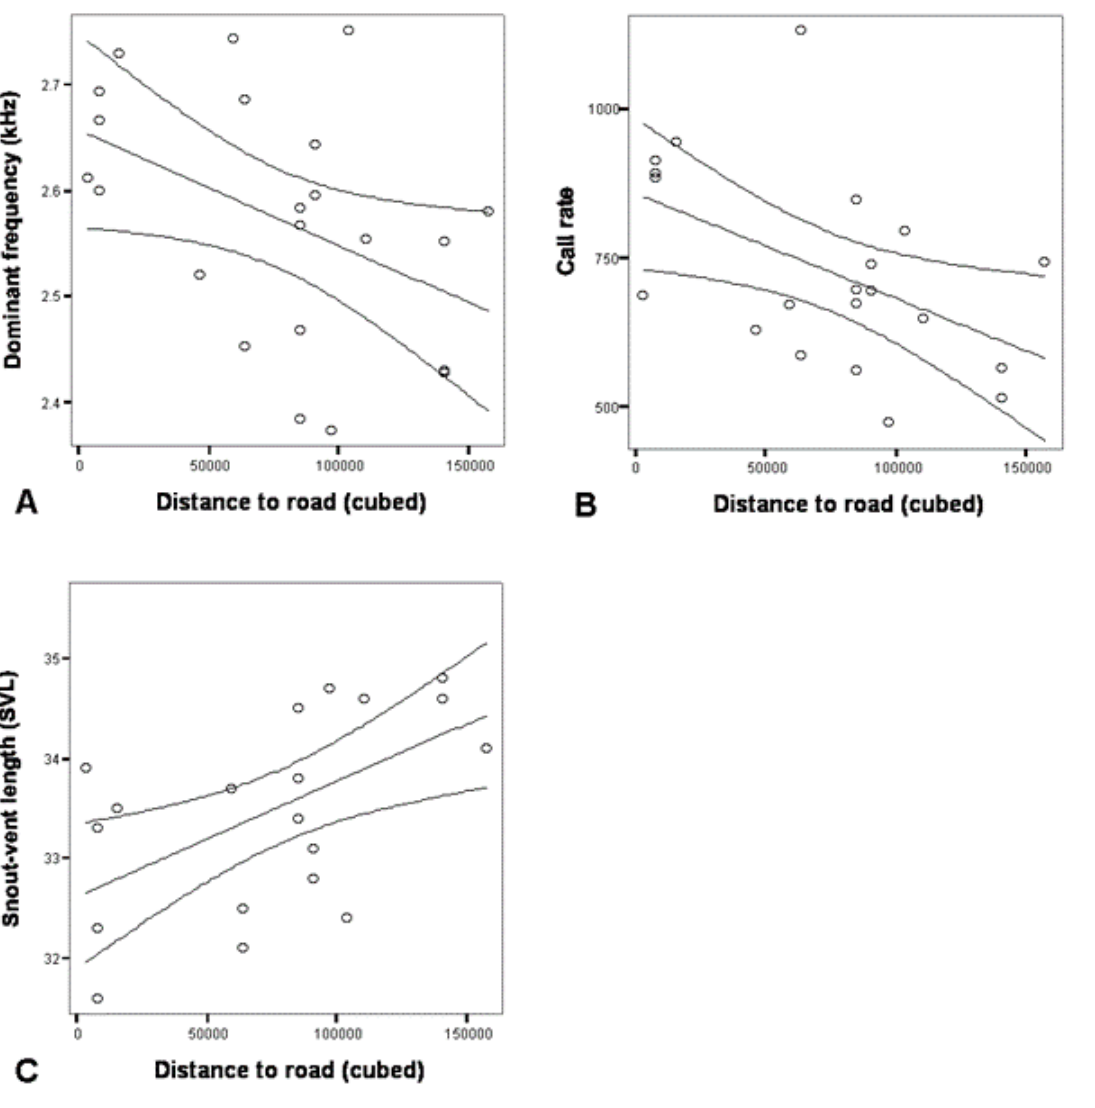
Fig. 4 . The relationship between (A) dominant frequency, (B) call rate, and (C) body size, and perpendicular distance to the road for L. rheocola within 55 m of the road on the upstream Streets Creek transect. Graphs show the regression line with upper and lower 95% confidence limits. The x-axis shows cubed distance to the road; the range of the untransformed data is 15-54